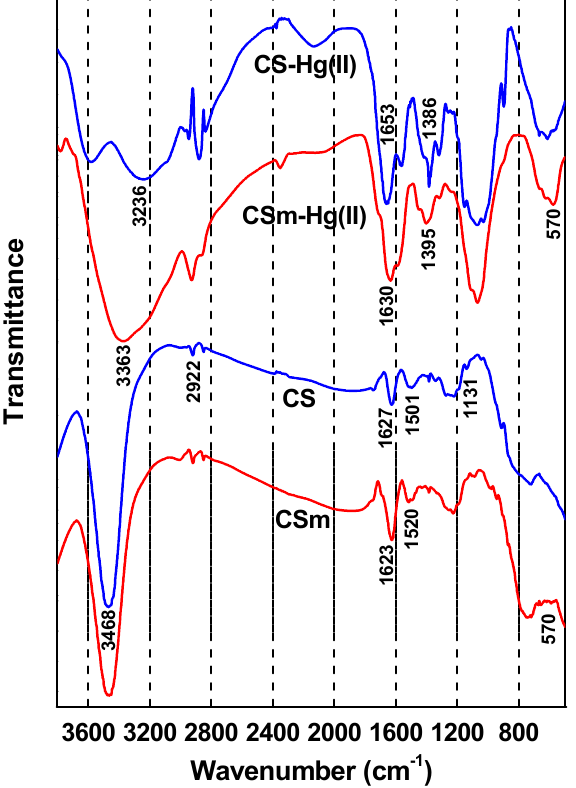
Figure 6. FTIR spectra of CS and CSm before and after Hg(II)